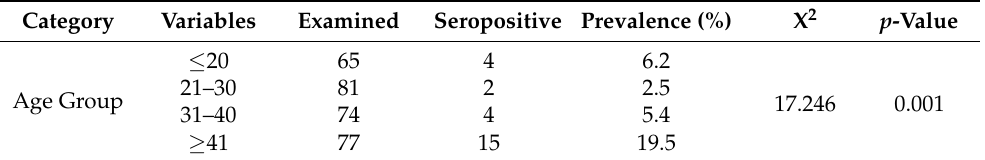
Table 2. Seroprevalence of C. burnetii antibodies in different age group of women of Punjab, Pakistan by using Chi-square analysis.